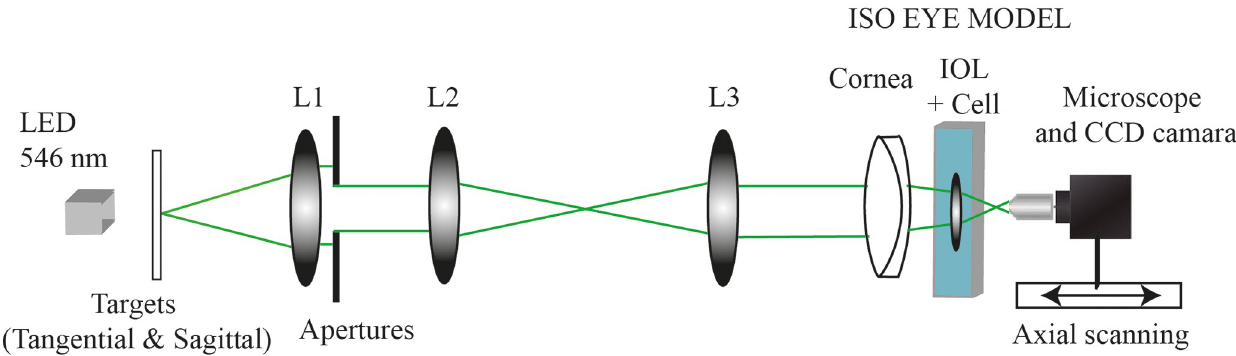
Fig 1. Schematic illustration of the experimental set up (PMTF) used to make the experimental measurements.